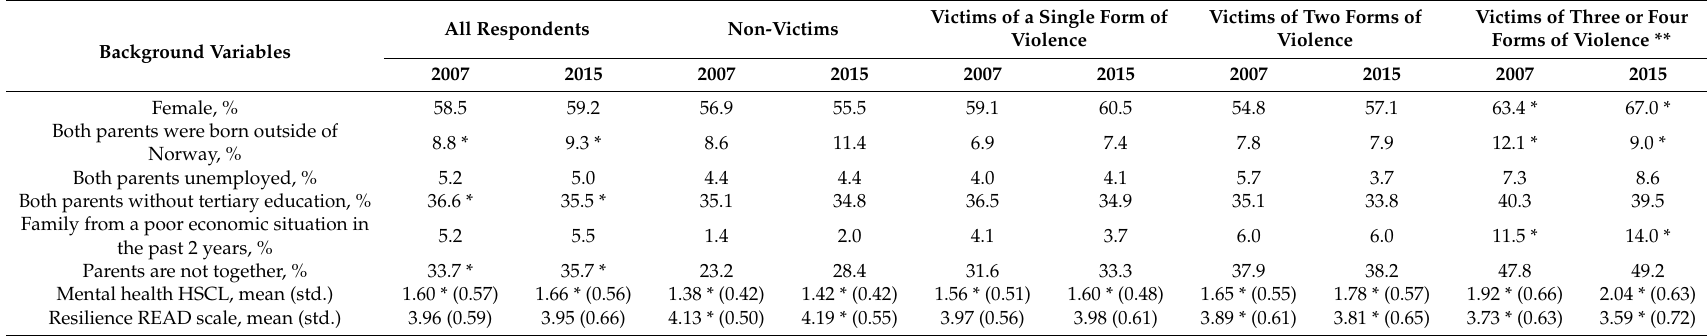
Table 2. Descriptive analyses of respondents’ background variables, social disadvantages, mental health, and Resilience Scale for Adolescents (READ) scores among youth groups without or with different victimization